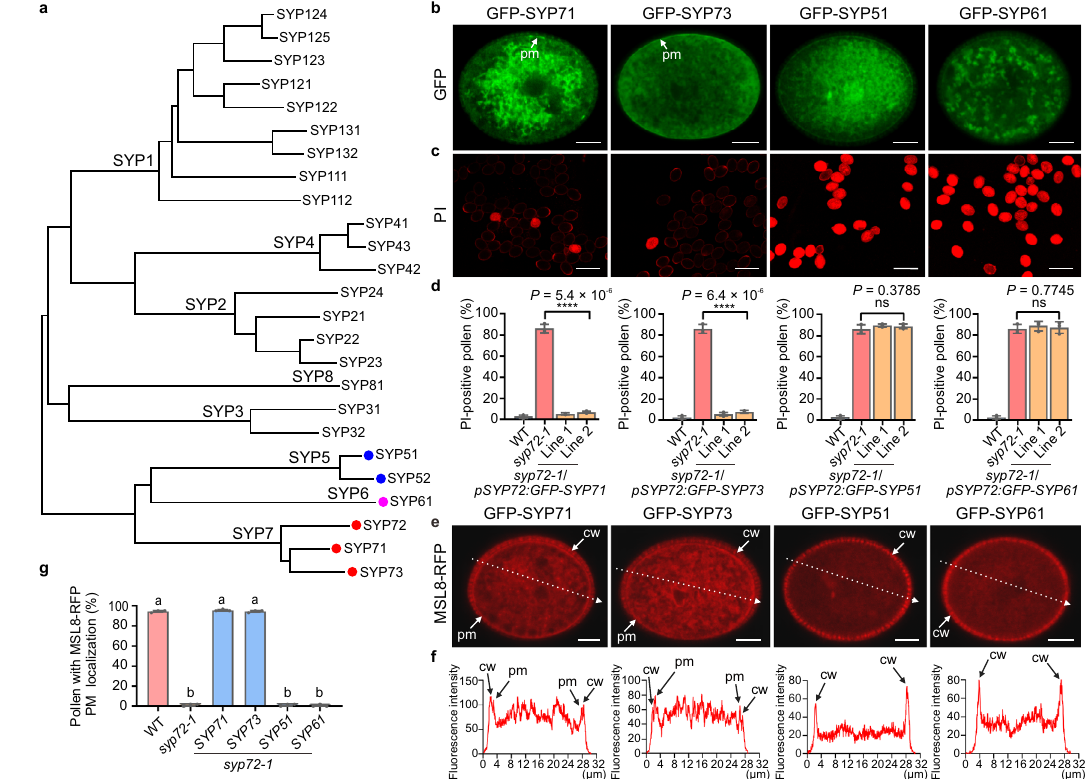
Fig. 6 Arabidopsis SYP7 SNAREs have a conserved role in protecting rehydrating pollen from hypoosmotic shock. a Phylogenetic relationship of Arabidopsis syntaxins. The tree was generated using the neighbour-joining method in MEGA7. The three members of the SYP7 subgroup are indicated with red dots. b Ectopic expression of SYP7 , SYP6 , and SYP5 genes under the control of the SYP72 promoter in syp72-1 pollen ( n = 10 biologically independent pollen grains). c Analysis of plasma membrane integrity during rehydration of pollen grains from the syp72-1 mutant stably expressing Arabidopsis syntaxin genes SYP71 , SYP73 , SYP51 , or SYP61 under the control of the SYP72 promoter, as observed by PI staining. Scale bars, 50 µ m. d Percentages of PI-positive pollen grains from syp72-1 transformed with Arabidopsis syntaxin genes SYP71 , SYP73 , SYP51 , or SYP61 . Two independent transgenic lines for each syntaxin gene were used for analysis. Data are the mean ± SD from three independent replicates. PI-positive pollen grains were scored from 300 pollen grains for each replicate. Two-tailed Student ’ s t test was used for statistical analysis (ns no signi fi cant difference, P > 0.05; **** P < 0.0001). e Subcellular localization of MSL8-RFP in the syp72-1 mutant stably expressing different Arabidopsis syntaxin genes. Scale bars, 5 µ m. f Pro fi le of relative fl uorescence intensity for MSL8-RFP (red line) along a dashed line (labelled in e ) drawn across a pollen grain. g The percentages of pollen grains showing MSL8-RFP plasma membrane signals ( e ) in syp72-1 plants transformed with different Arabidopsis syntaxin genes. Data represent the mean ± SD from three independent experiments, with 60 pollen grains analysed in each experiment ( n = 180). Ordinary one-way ANOVA with Tukey ’ s multiple comparisons test was used for statistical difference analysis between different groups. P < 0.05 was considered statistically signi fi cant. Different letters above the bars indicate signi fi cant differences between groups. cw cell wall, pm plasma 579H09) was obtained from the Nottingham Arabidopsis Stock Centre (NASC). Arabidopsis Columbia-0 (Col-0), T-DNA insertion lines, reporter lines including UBQ10, NPSN12-mCherry; UBQ10, mCherry-Rab A1e; UBQ10, mCherryRab A1g; UBQ10, mCherry-Rab F2a; UBQ10, mCherry-VAMP711; UBQ10, mCherry- Rab A5d; UBQ10, mCherry-Rab C1; UBQ10, mCherry-Rab D1; and UBQ10, mCherry-VTI12 12 , and Nicotiana benthamiana were cultured in a greenhouse at 22± 1°C, 16/8h (light/dark).